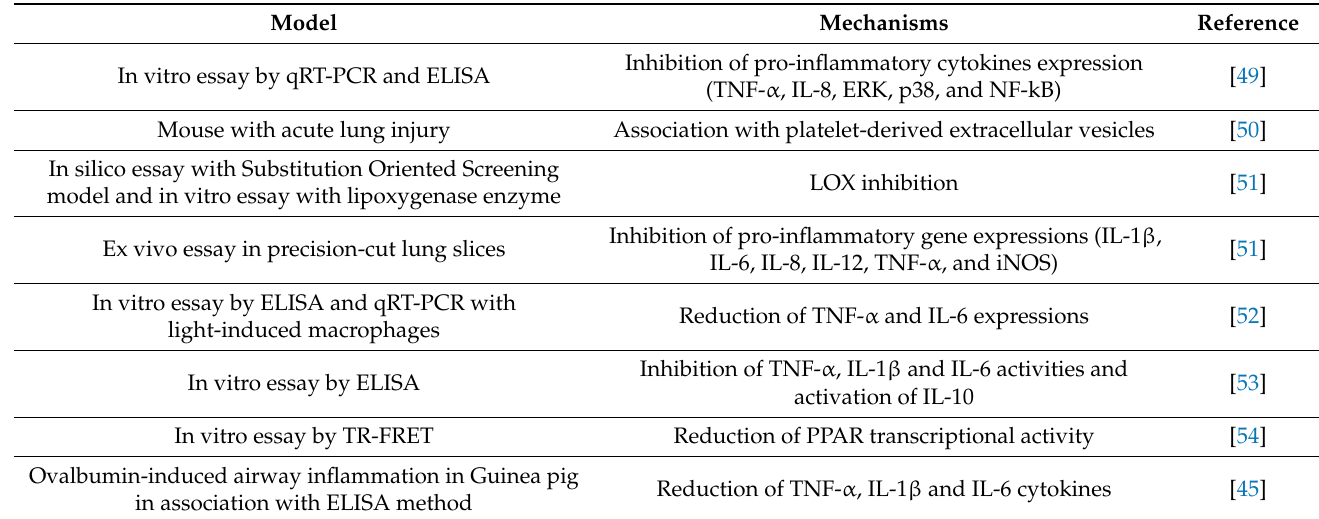
Table 2. Summary of the thiophene-based compounds that modulate gene expression and/or inflammatory cytokines.